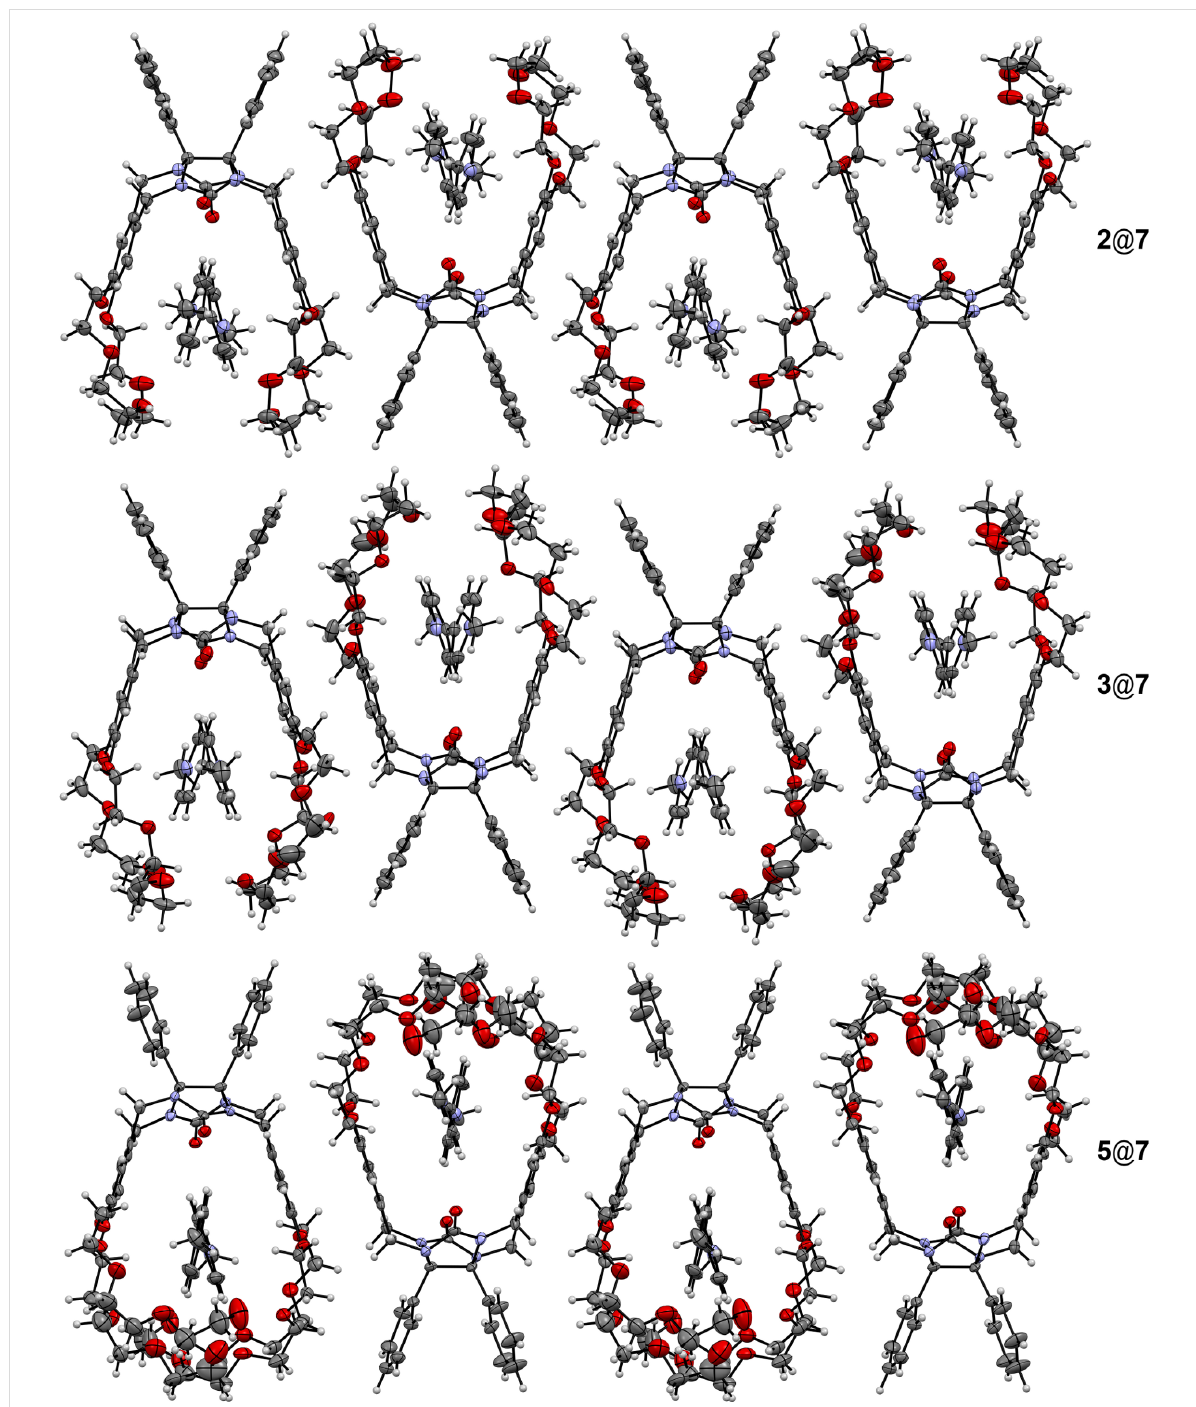
Figure 7: Crystal packing of molecules in complexes of clips 2 , 3 and 5 with paraquat ( 7 ). Anions and solvate molecules are omitted for clarity.